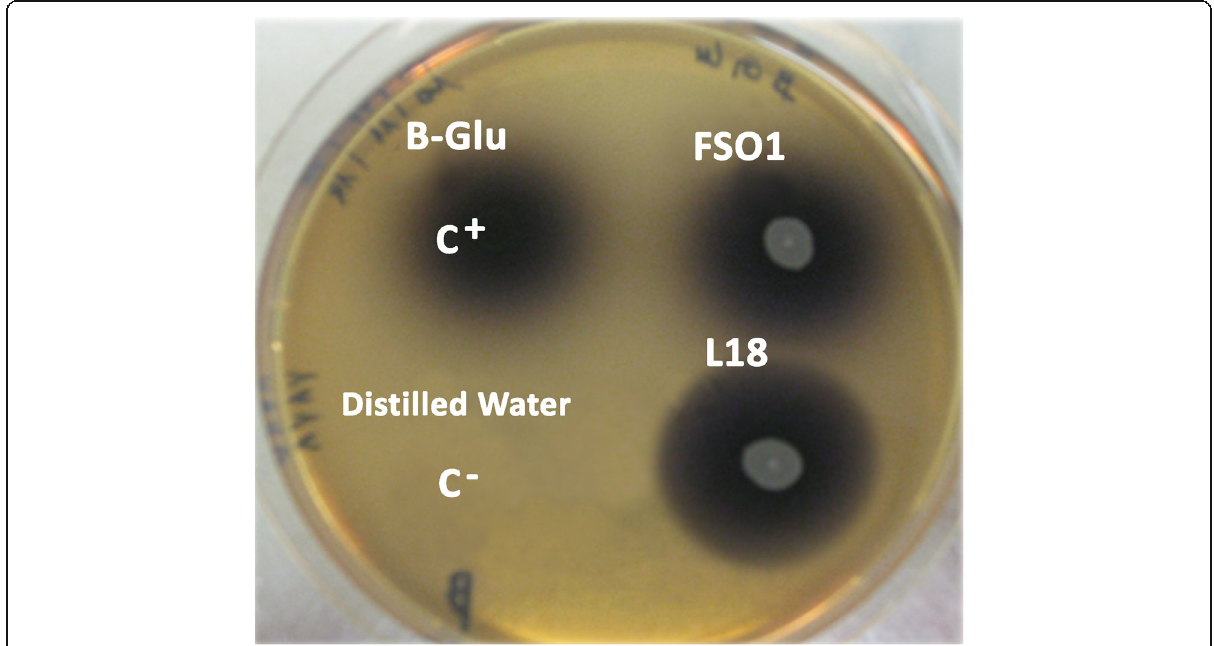
Fig. 1 Hydrolysis of esculin obtained on esculin-based medium after 2 days of incubation at 30 °C of L. plantarum (FSO1) and C. pelliculosa (L18) (legend: C + (B-Glu), commercial enzyme ( β -glucosidase EC 3.2.1.21); C - : distilled